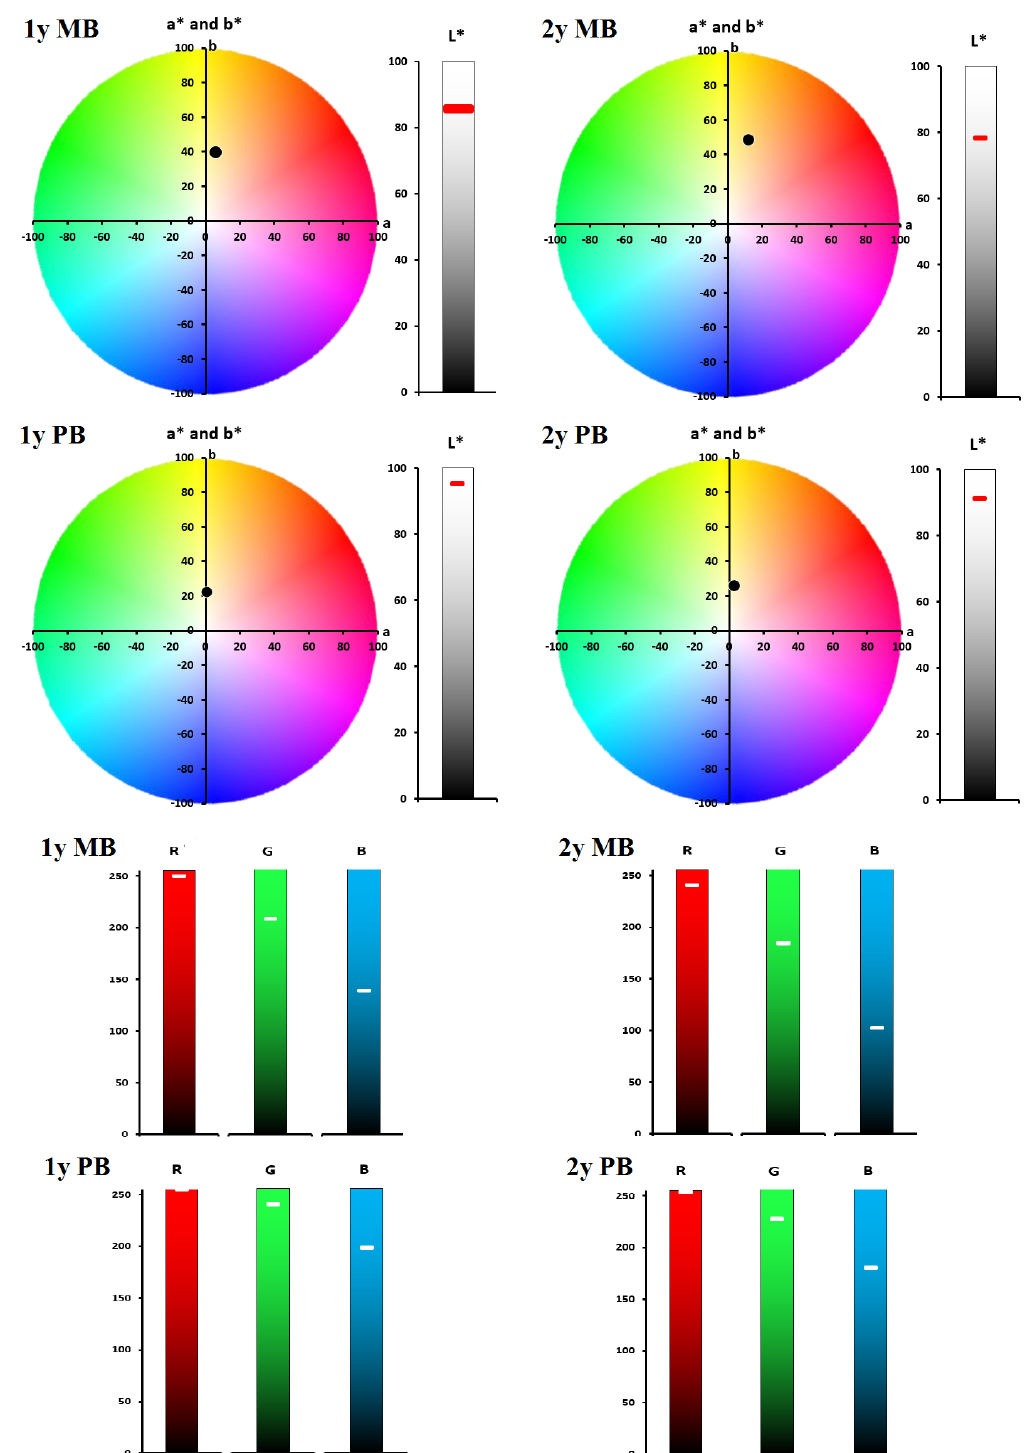
Figure 7. Color space for control (MB) and plasma treated (PB) Bârze¸sti must, according to [83]. The black dots represent the points ( a* , b* ) of the samples, while the red horizontal line in the bar graphs represents the L* , R, G and B of the 1 and 2 year old